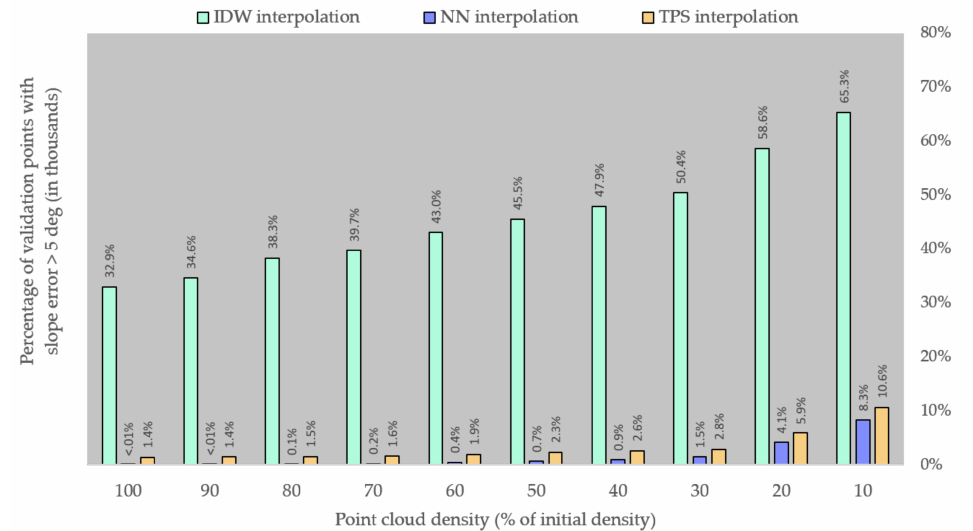
Figure 9. Number of validation points with a slope error over the 5-degree threshold.